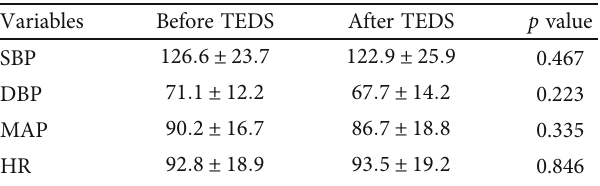
Table 2: Di ff erences between systolic blood pressure, diastolic blood pressure, mean arterial pressure, and heart rate from before to after the